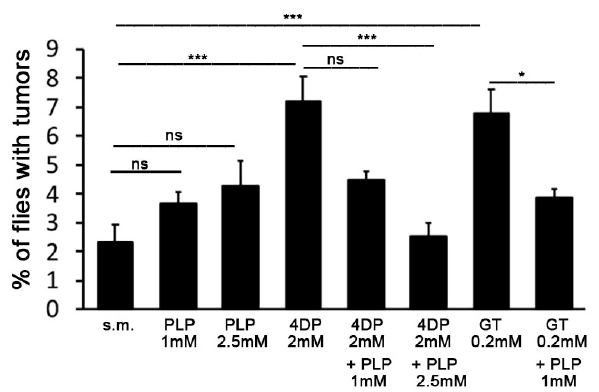
Figure 2. PLP supplementation rescues wts tumors. Each column represents the mean value ± SEM. For each condition, at least 500 flies were examined in three different experiments. *, *** significant Chi-square test with p < 0.05 and <0.001, respectively. ns = non-significant Chi-square test; s.m. = standard medium; PLP = pyridoxal 5 (cid:48) -phosphate; 4DP = 4-deoxypyridoxine; GT = ginkgotoxin. Table 2. Distribution of wts tumors on the body of wts/+ flies reared in PLP-supplemented medium. Treatment Tot. Flies